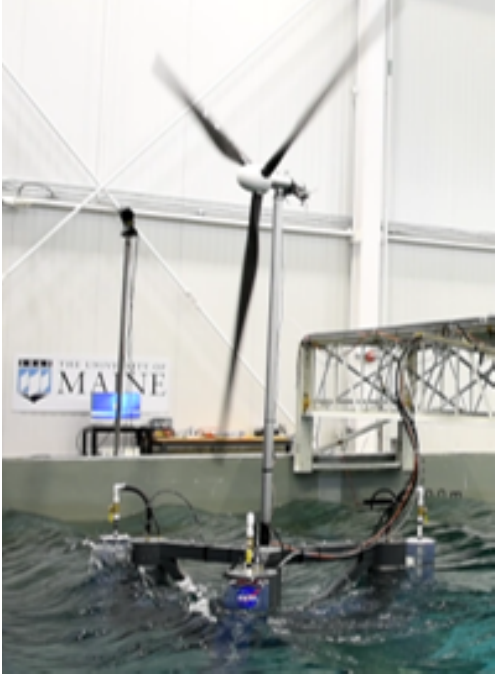
Figure 1. A photo from the 2018 model